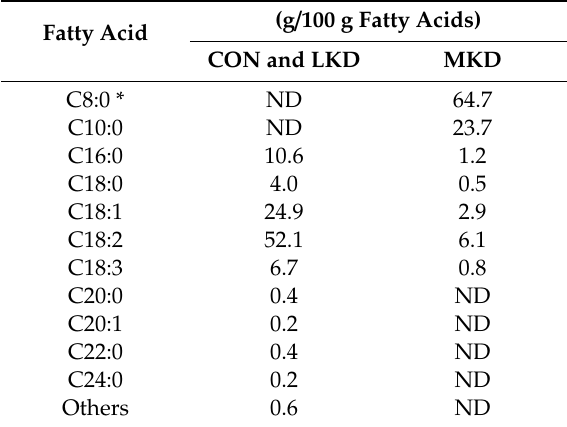
Table 2. Fatty acid compositions of the experimental